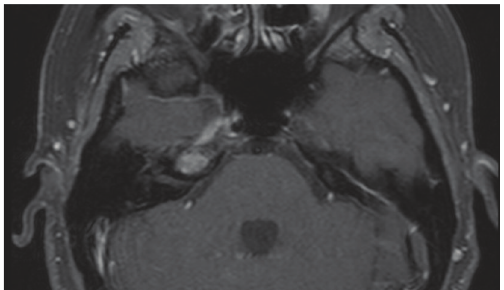
Figure 1: Axial T1-weighted image shows a hyperintense lesion in the right petrous apex.